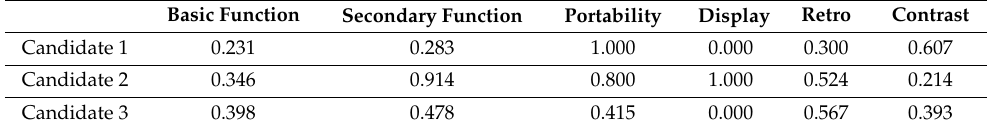
Table 3. Proposed design specification candidates for selection.